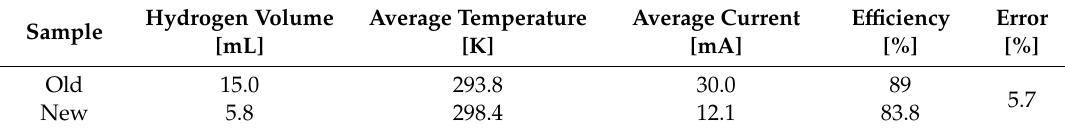
Table 2. Comparison of CNF solution sample results.